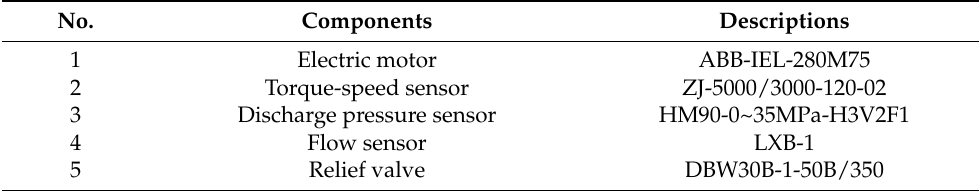
Figure 4. Layout and schematic diagram of the test rig. Table 2. Detailed descriptions of the test rig.